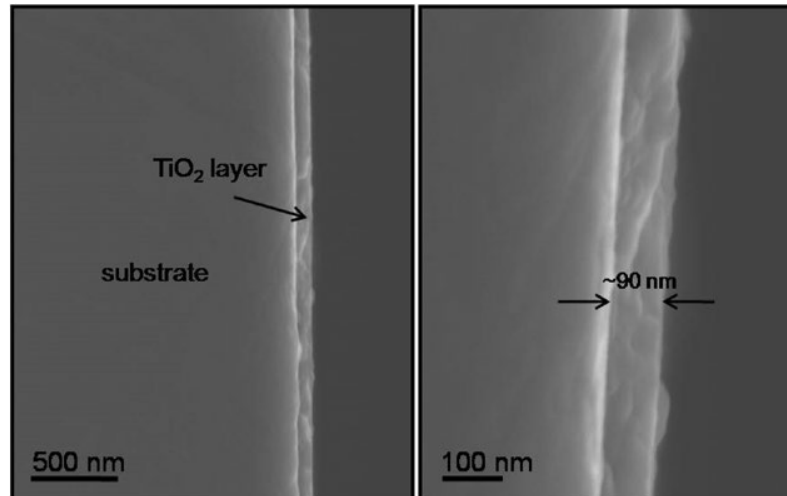
Figure 9. SEM micrographs of a cross-section of undoped thin film, calcined at 600 °C.